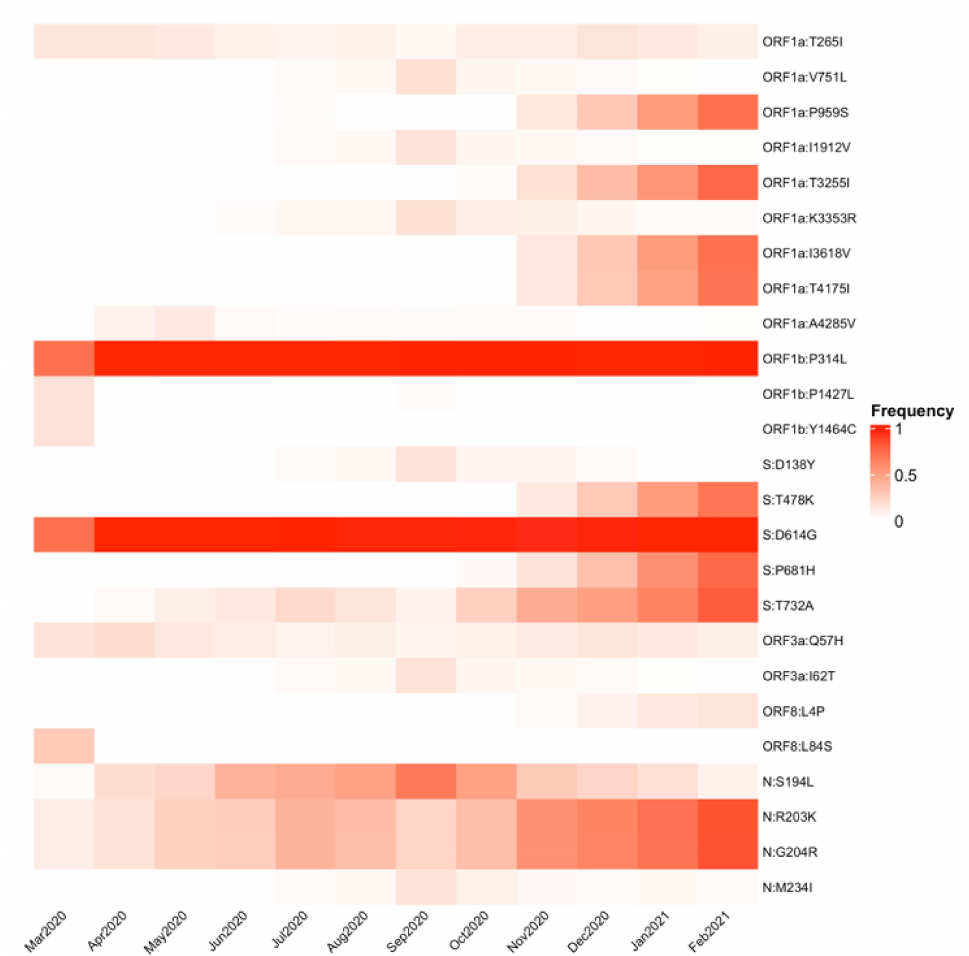
Figure 3. Heatmap of monthly amino acid mutation frequency. The heatmap shows the changes in mutation frequency from March 2020 to February 2021. Only nonsynonymous substitutions with a 10% frequency in at least one month are